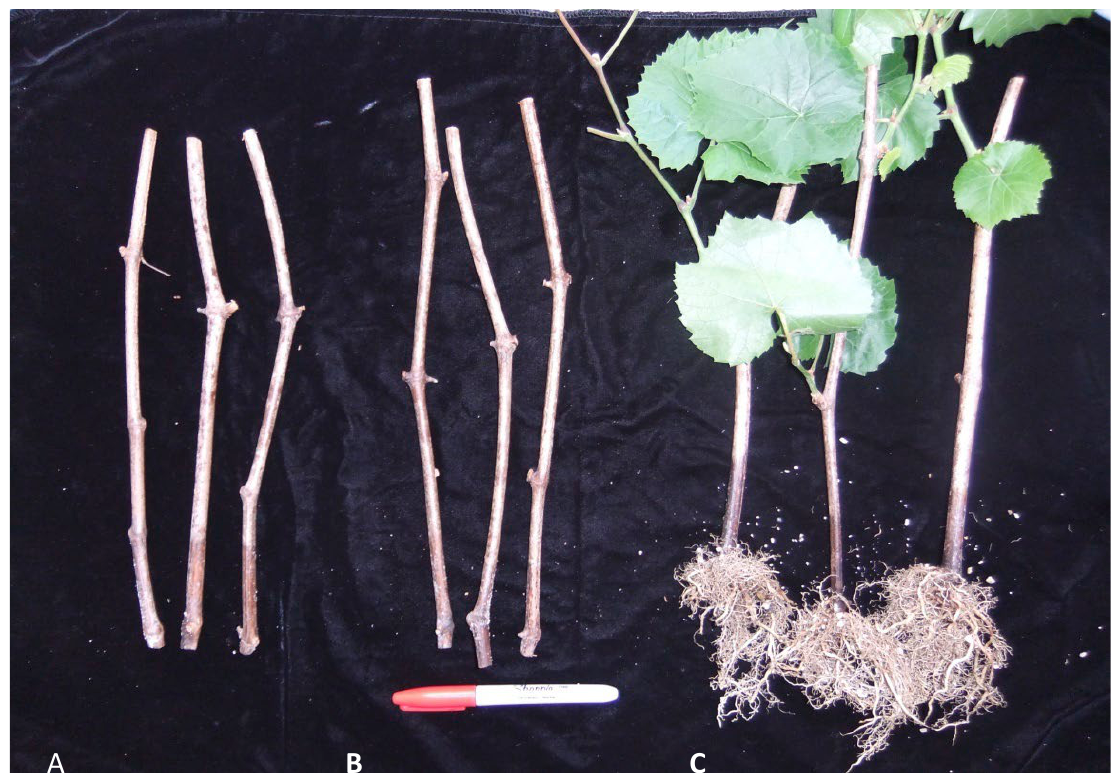
Figure 1. Effects of hot-water treatment on root development and bud burst of rootstock canes (variety 5C). Treatments were: (A) 53°C-30 min; (B) 53°C-60 min; (C) control canes with no